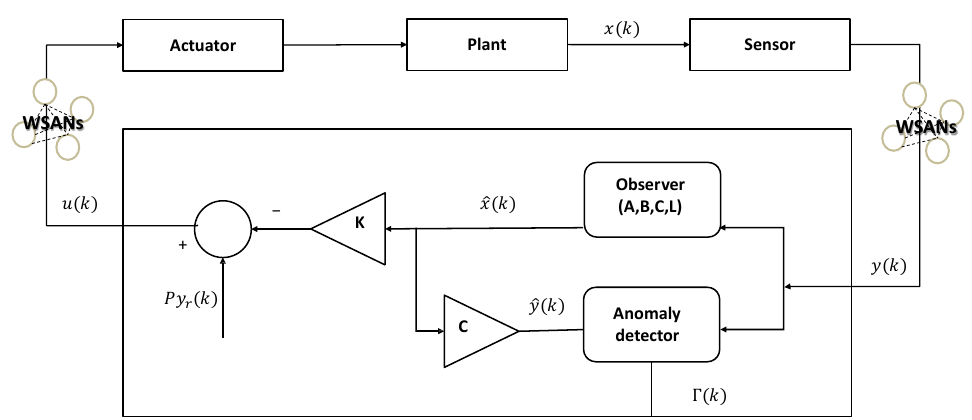
Figure 1. System model of industrial